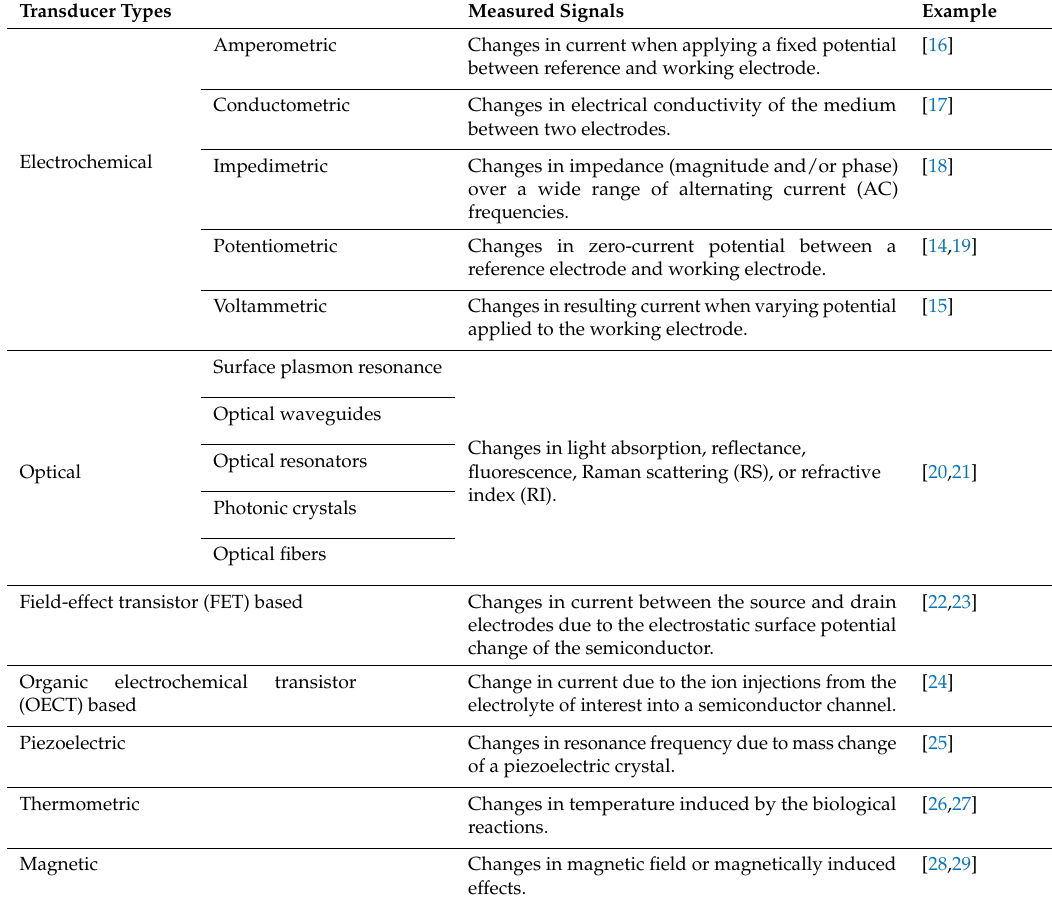
Table 1. Types of biosensor transducers and corresponding signals during